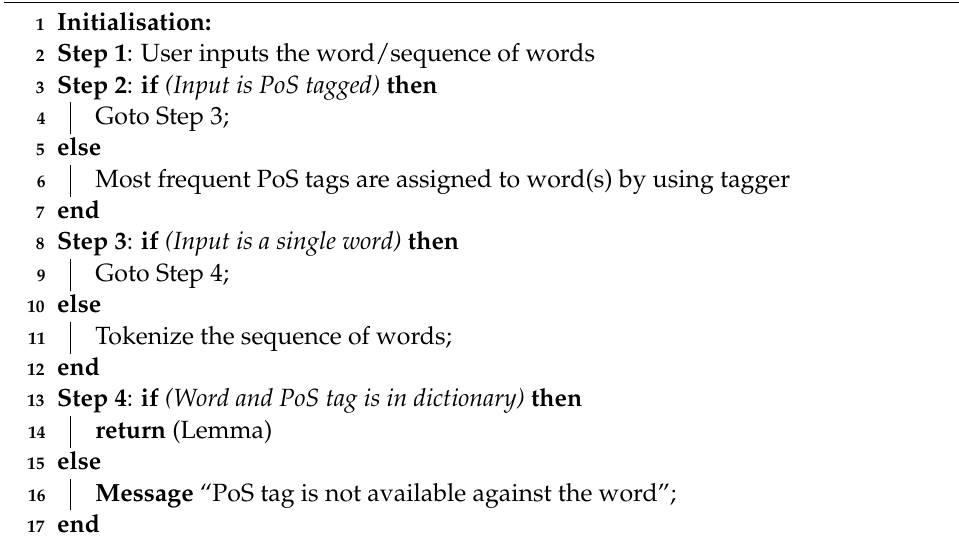
Algorithm 1: The execution steps of the proposed